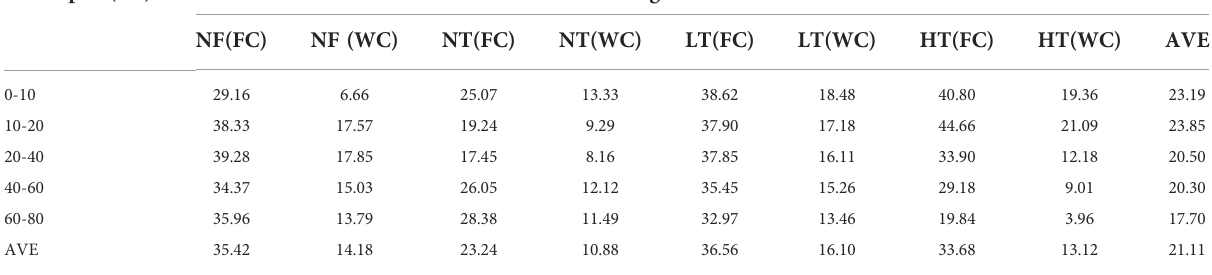
TABLE 2 Field capacity and wilting coef fi cient of P. crassifolia under different management practices. Soil